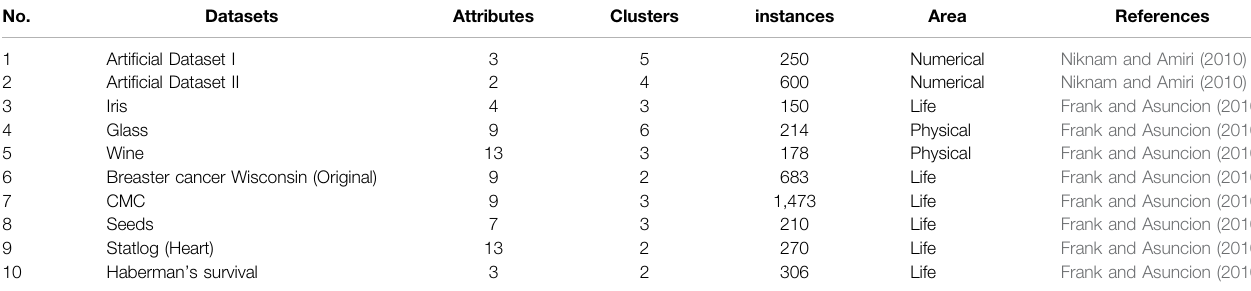
TABLE 2 | Details of the ten clustering benchmark